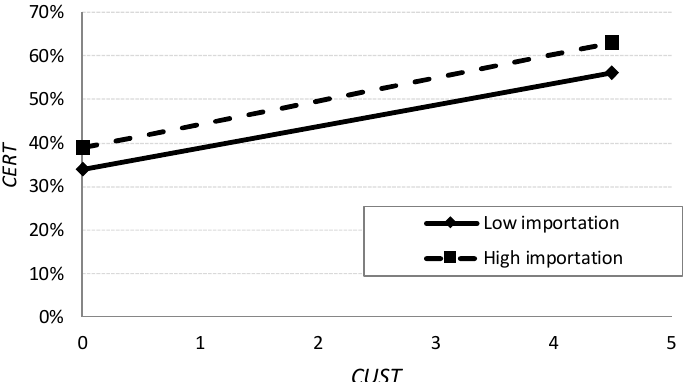
Figure 5. Interaction effects TYPE × CUST. Note: CERT is the percentage of certified production sold by the wholesaler; CUST is the degree of customer requirements, where 1 is lowest and 5 is maximum; TYPE indicates where the majority of the wholesaler’s produce comes from importation.